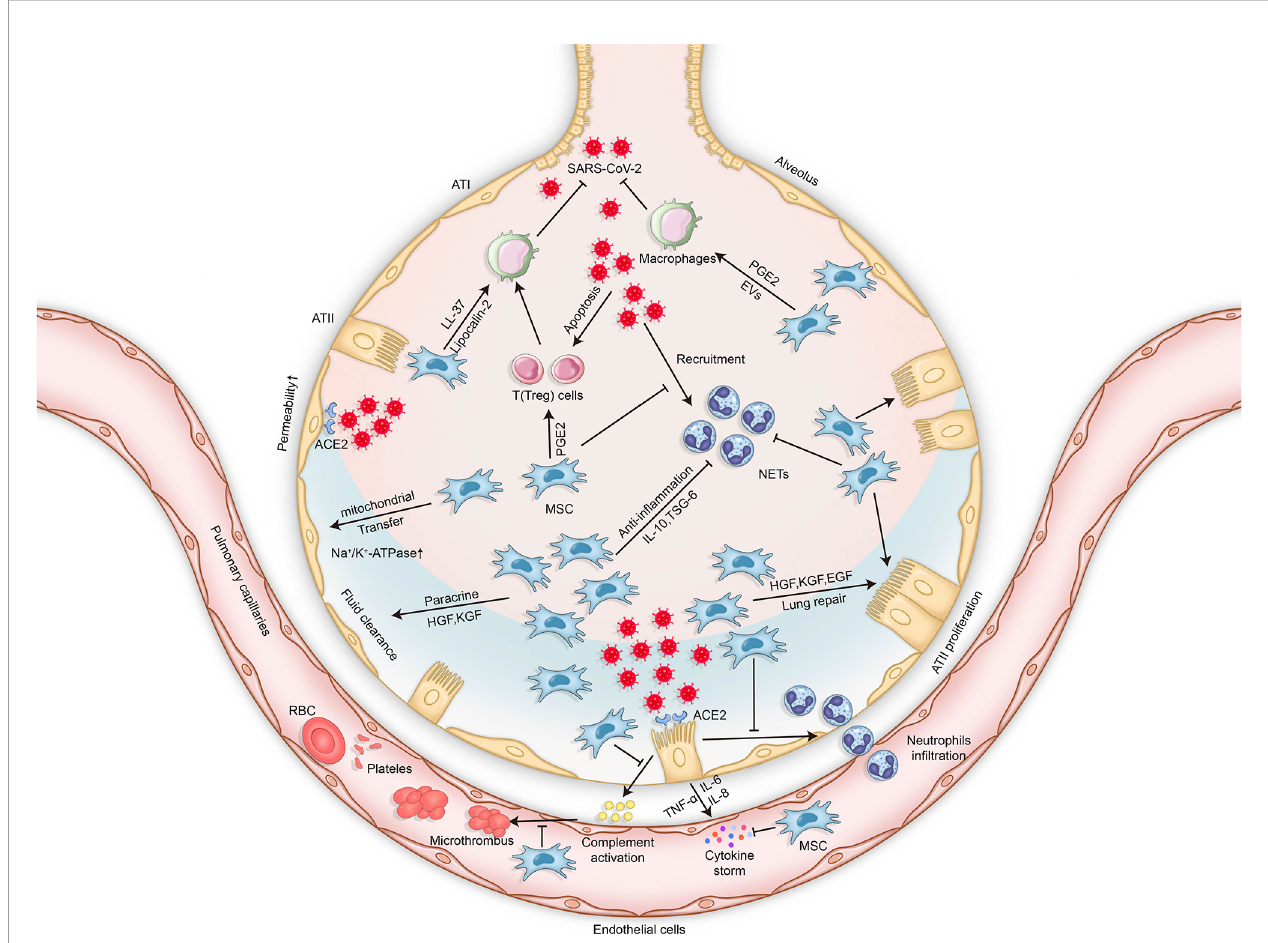
FIGURE 1 | Mechanisms of lung injury in COVID-19 and potential therapeutic effects of MSCs in COVID-19-related respiratory lung injury. The mechanisms of lung injury in COVID-19 include, but are not limited to, aberrant immune host responses accompanied by a “ cytokine storm, ” excessive neutrophil activation, dysregulation of immune cells, endothelial dysfunction, and immunothrombosis formation. The potential therapeutic effects of MSCs in COVID-19 involve multiple mechanisms via their secretion of soluble paracrine factors and possible mitochondrial transfer. MSCs can enhance microbe clearance, resolve in fl ammation, modulate immunity, improve lung permeability, increase alveolar fl uid clearance, and promote lung epithelial and endothelial repair. SARS-CoV-2 , severe acute respiratory syndrome coronavirus 2; MSCs , mesenchymal stromal cells; ATI , alveolar type 1 cells; ATII , alveolar type 2 cells; TNF , tumor necrosis factor; IL , interleukin; ACE2 , angiotensin-converting enzyme 2; PGE2 , prostaglandin E2; KGF , keratinocyte growth factor; TSG-6 , TNF-stimulated gene 6; HGF , hepatocyte growth factor; EGF , epidermal growth factor; EVs , extracellular vesicles; NETs , neutrophil extracellular traps; RBCs , red blood